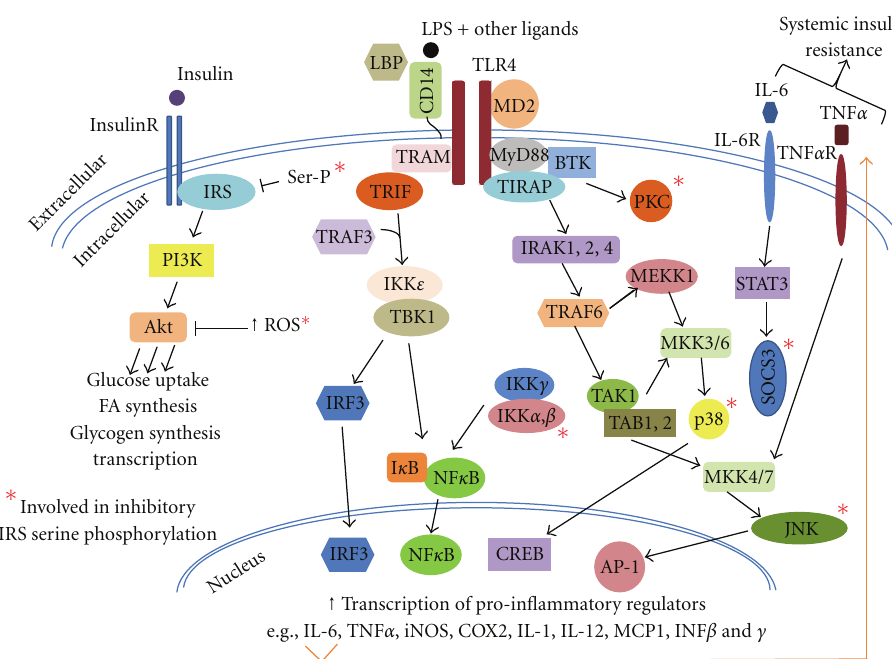
Figure 1: Schematic of TLR4 signaling cascades. Activation of TLR4 signal transduction through MyD88/TIRAP and TRAM/TRIF pathways leads to activation of innate immune responses and inhibition of insulin signal transduction, primarily through IRS serine phosphorylation. Additional cellular responses to TLR4 activation not shown include activation of NADPH oxidase, cytoskeletal rearrangement, and internalization of TLR4 complexes to endosomal compartments.